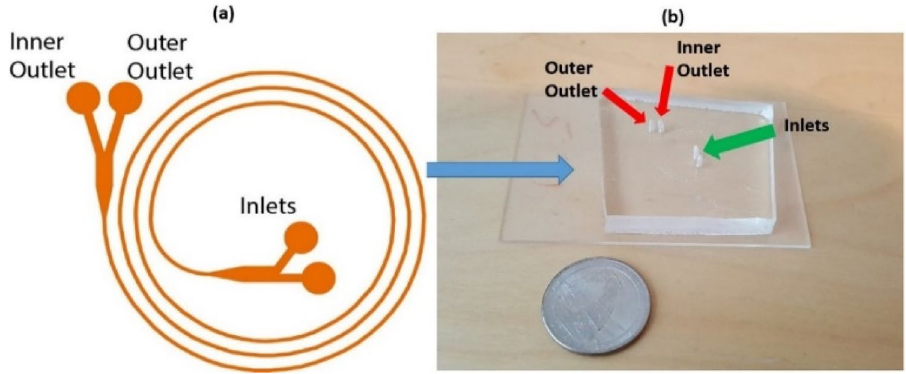
in the Supplementary Information. Polyethylene oxide (PEO) dissolved in 1× PBS was used as the viscoelastic reagent in the spiral channel focusing tests. The PEO solution was prepared by mixing PEO powder that has a molecular weight of 2 × 10 6 g/mol (Sigma-Aldrich, St. Louis, MO) with PBS. PEO concentrations ranging from 0.01 to 0.03% were used in the experiments. The polymer solution overlap concentration c* is estimated by measuring the intrinsic viscosity utilizing a capillary viscometer, c* = 1.1 mg/ml 47 . The PEO solutions used in these experiments were considered dilute as the PEO concentration was less than c*. The PEO solution relaxa- tion time was estimated by Zimm theory 48 . The properties of the PEO solution are listed in Table 1. Instrumentation. The spiral channel used in this work had a 100 µm width and 25 µm height with 7 to 9 mm radius and 3 loops. A picture of the design and the fabricated device is shown in Fig. 2. A Vanguard fluorescence microscope model 1486FL coupled with an AmScope microscope camera was used to take the images of the fluorescent particles through the inertial focusing tests. Two Dionex RF-2000 fluorescence detec- tors (Dionex Softron GmbH, Germany) were used for the detection of exiting particles at the outlet ports of the spiral channel. One of the detectors was set at the excitation wavelength of 365 nm and the emission wave- length of 415 nm for the detection of blue-dyed 28 nm particles. The other fluorescence detector was set at the excitation wavelength of 505 nm and the emission wavelength of 550 nm for the detection of yellow green dyed